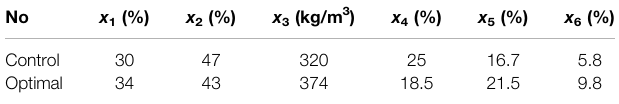
TABLE 8 | Mix proportion of Control and Optimal.